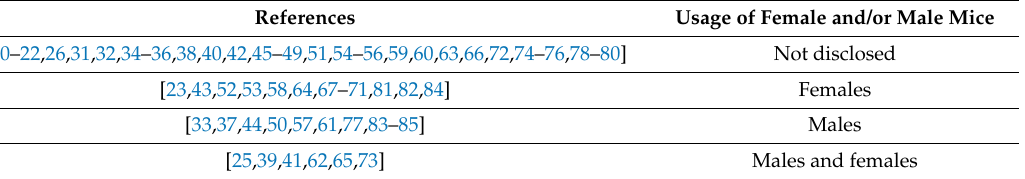
Table 1. Published studies using the mouse model of granulocytic anaplasmosis.